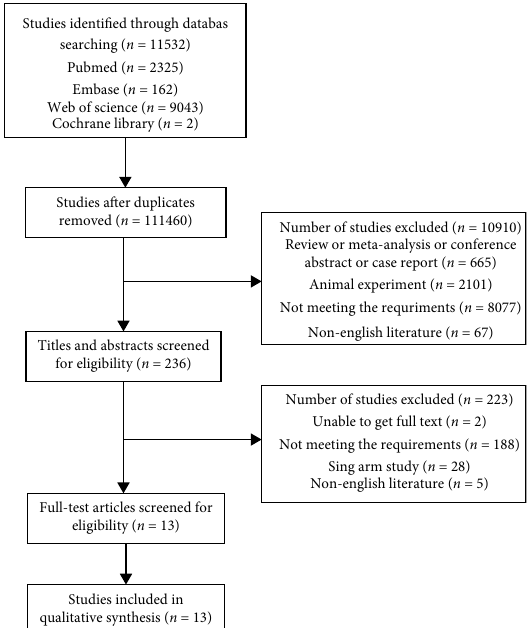
Figure 1: The fl ow chart of literature